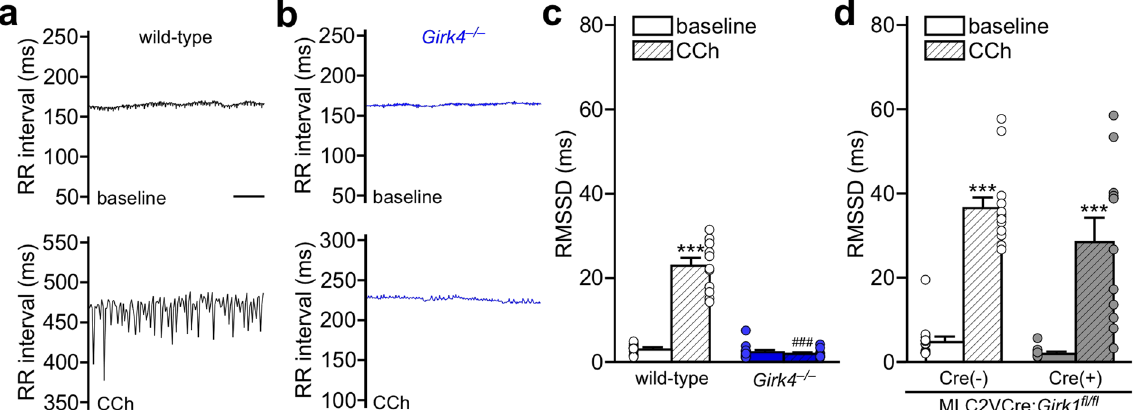
Figure 6. Time-domain HRV analysis of constitutive and ventricle-specific Girk − / − mice. ( a , b ) RR tachograms for anesthetized wild-type ( a ) and Girk4 − / − ( b ) mice, at baseline and following injection of CCh (1.0 mg/ kg i.p.). Scale: 10 s. ( c ) Summary of RMSSD data at baseline and following injection of CCh for wild-type (n = 12) and Girk4 − / − (n = 13) mice. Two-way ANOVA analysis revealed an interaction between genotype and treatment (F 1,23 = 158.7, P < 0.001). Symbols: *** P < 0.001 vs. baseline (within genotype); ### P < 0.001 vs. wild-type (within treatment). ( d ) Summary of RMSSD data at baseline and following injection of CCh for MLC2VCre( − ): Girk1 fl/fl (n = 13) and MLC2VCre( + ): Girk1 fl/fl (n = 12) mice. There was a significant main effect of treatment (F 1,23 = 96.3, P < 0.001), but no main effect of genotype (F 1,23 = 3.2, P = 0.087) or interaction between genotype and treatment (F 1,23 = 0.66, P = 0.43). Symbols: *** P < 0.001 vs. baseline (within